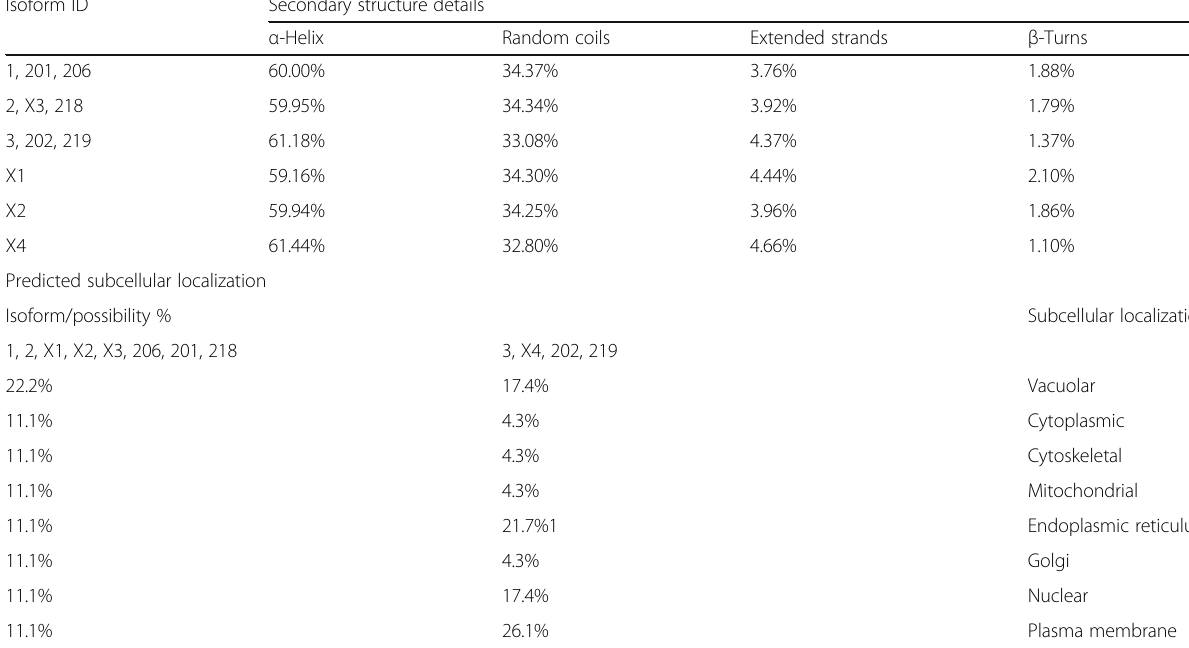
Table 2 The secondary structure details and the subcellular localization of the STAG3 peptides